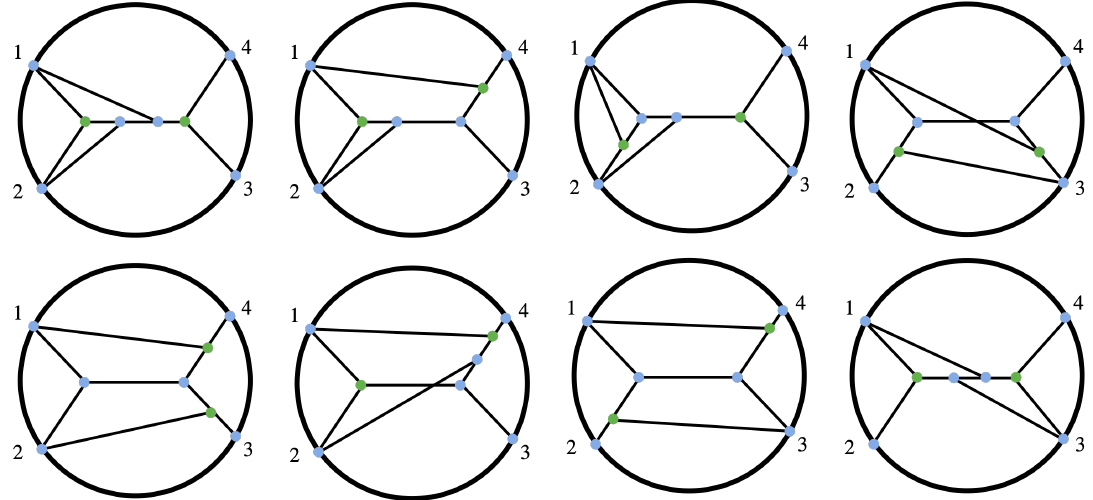
Figure 14 . Examples of diagrams with two bound states and only cubic vertices. Using the integrated vertex identity at the green indices reduces the diagrams to the two basic diagrams W I and W II ••◦◦